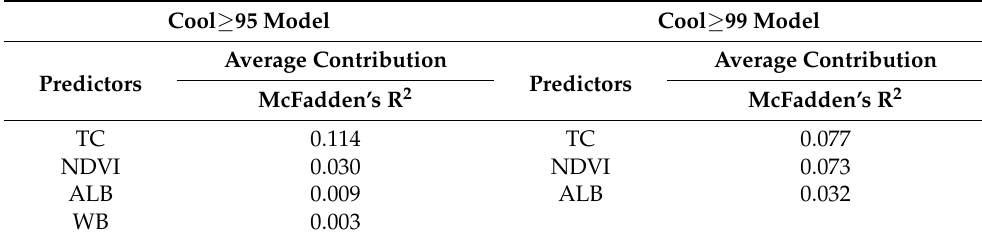
Table 7. Average contribution by predictor (General Dominance Analysis of selected Cool-spot logistic